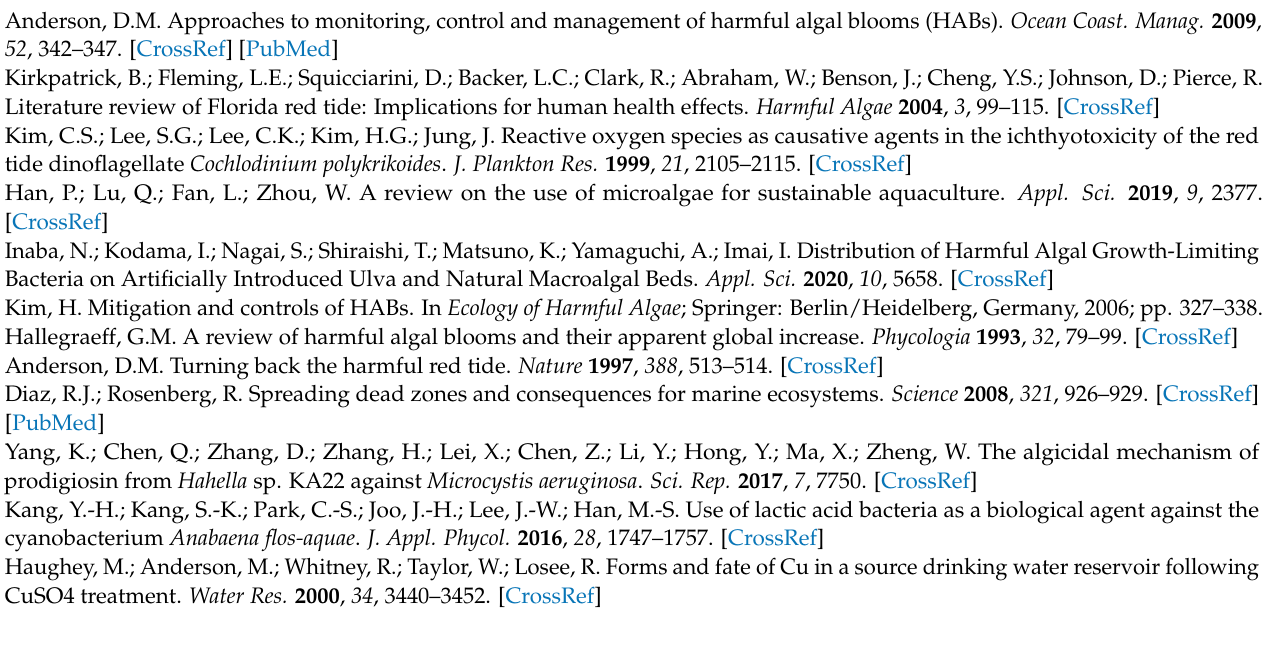
Figure S3: Optical microscope and fluorescent images of cell lysis of Anabaena sp. KVSF7 due